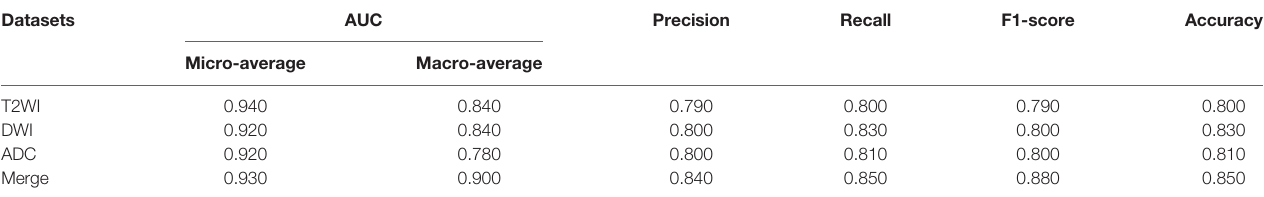
TABLE 3 | Results obtained by the RF models constructed with different datasets.